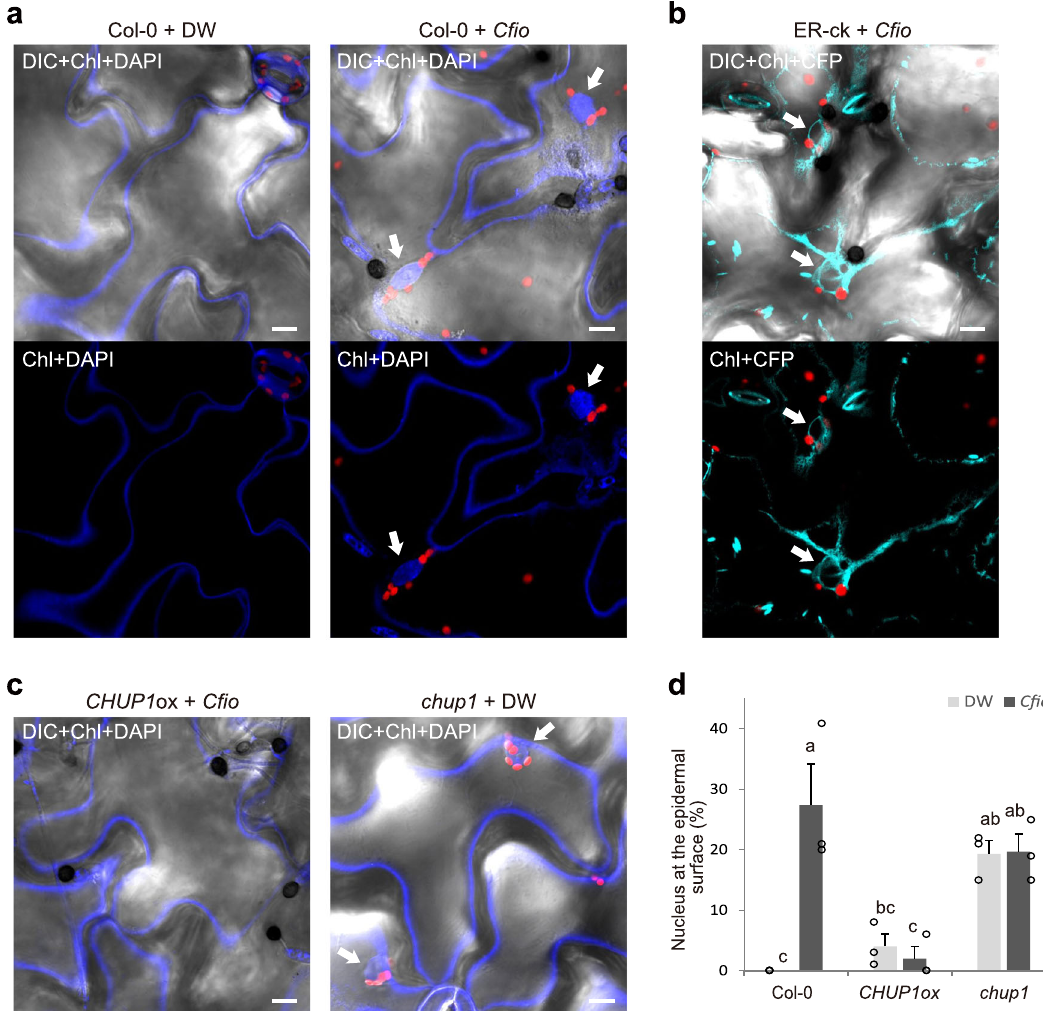
Fig. 10 The nucleus dynamically responds to fungal entry trial in an ECR-dependent manner. a Simultaneous observation of chloroplasts and nuclei in ECR-activated epidermis. The surface of C fi o -inoculated cotyledons of Col-0 was examined at 3 dpi. The chloroplasts and nuclei were visualized by chlorophyll auto fl uorescence and DAPI staining, respectively. DW was used as a control. The arrows indicate nuclei. b Simultaneous observation of chloroplasts and ER around nuclei in ECR-activated cells. The surface of C fi o -inoculated cotyledons of the transgenic plant line ER-ck expressing ER-CFP was observed at 3 dpi. The arrows indicate perinuclear ER. c Simultaneous observation of chloroplasts and nuclei in ECR-defective plants at 3 dpi. C fi o - inoculated cotyledons of CHUP1 ox plants were investigated. DW was spotted onto chup1 mutant as a control. The arrows indicate nuclei. d The ratio of epidermal cells with surface nuclei was investigated at 3 dpi. A total of 100 cells in contact with the melanized appressorium were observed. Scale bar, 10 µ m. The means and SE were calculated from three independent plants. Means not sharing the same letter are signi fi cantly different ( P < 0.05, two-way ANOVA with Tukey ’ s HSD